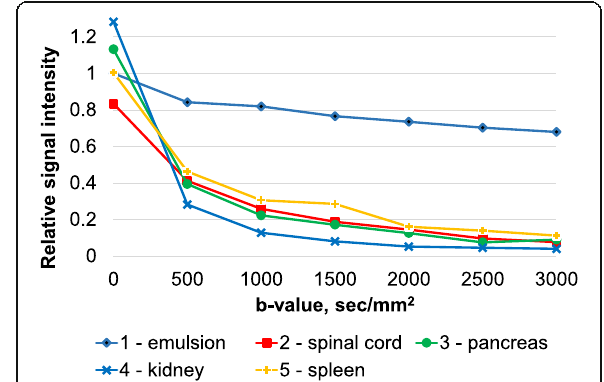
Fig. 8 The results of the in vivo study with an extracorporeal signal source: cross plots of the abdominal organs signal intensities relative to the reference signal (emulsion) at increasing b